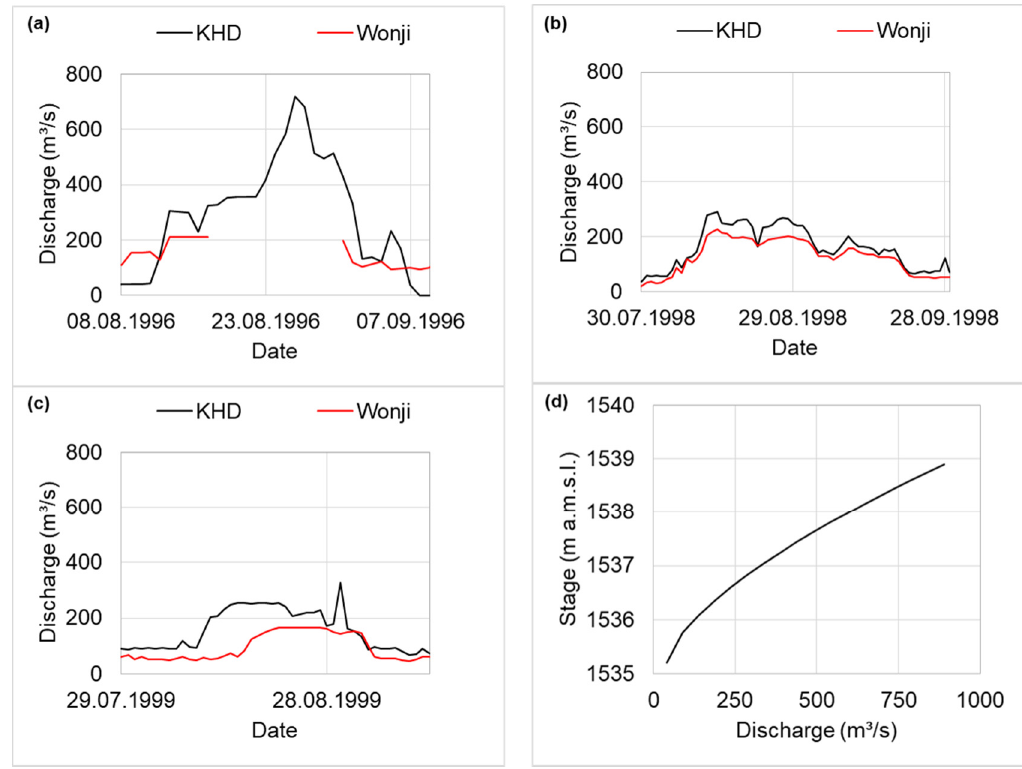
Figure 5. Awash River flow data: ( a ) hydrograph of the August 1996 flood flow at KHD and Wonji gauging stations; ( b ) hydrograph of the summer 1998 flood flow at KHD and Wonji gauging stations; ( c ) hydrograph of the August 1999 flood flow at KHD and Wonji gauging stations; ( d ) stage–discharge relationship of Awash River at Awash II derived using overflow equation for broad-crested weir.